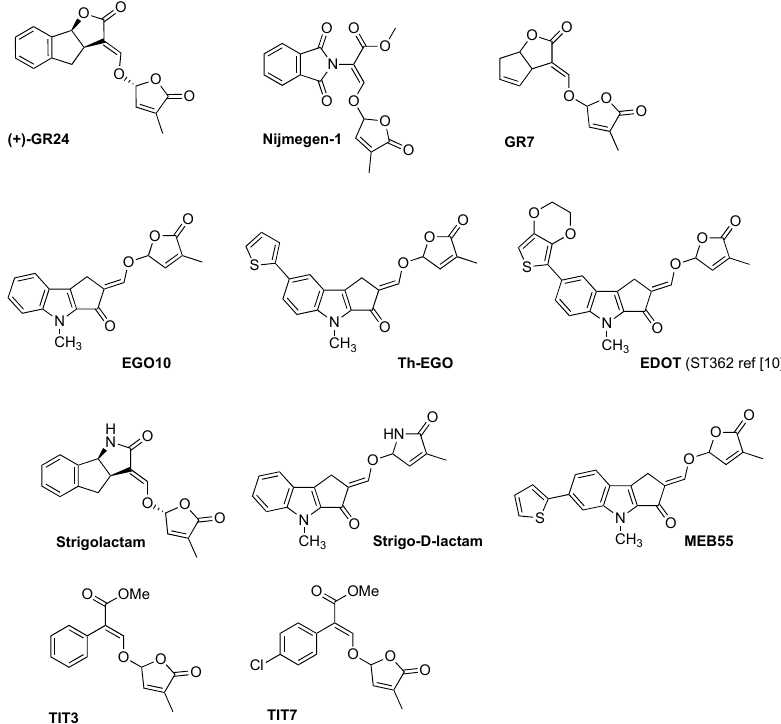
Figure 2. Panel of synthetic strigolactones. (+)-GR24 [6], Nijmegen-1 [19], GR7 [18], EGO10 [20], TH-EGO [20], EDOT [20], Strigolactam [21], Strigo-D-lactam [22], MEB 55 [10], TIT3 and TIT7 [28].